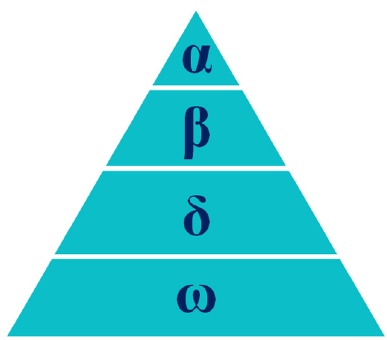
Figure 14. Dominant hierarchy of grey volves (dominance increasing from bottom to top).